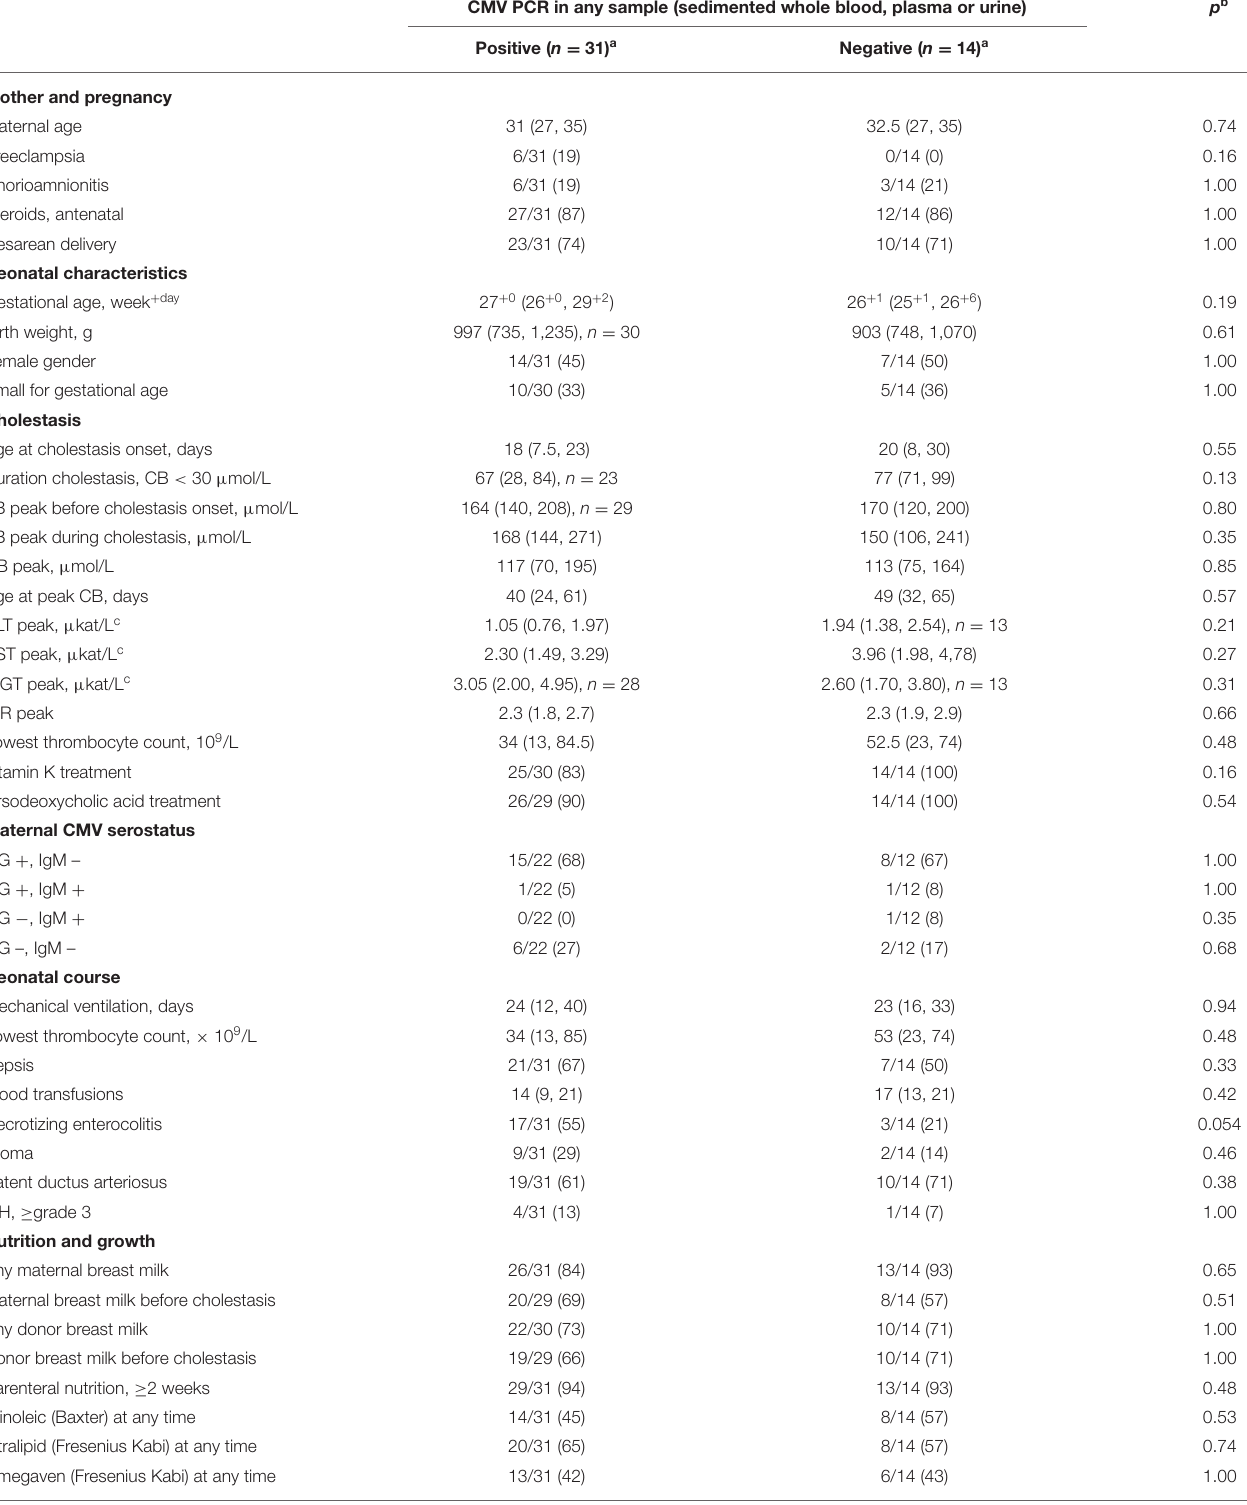
TABLE 3 | CMV-positive vs. CMV-negative cholestatic